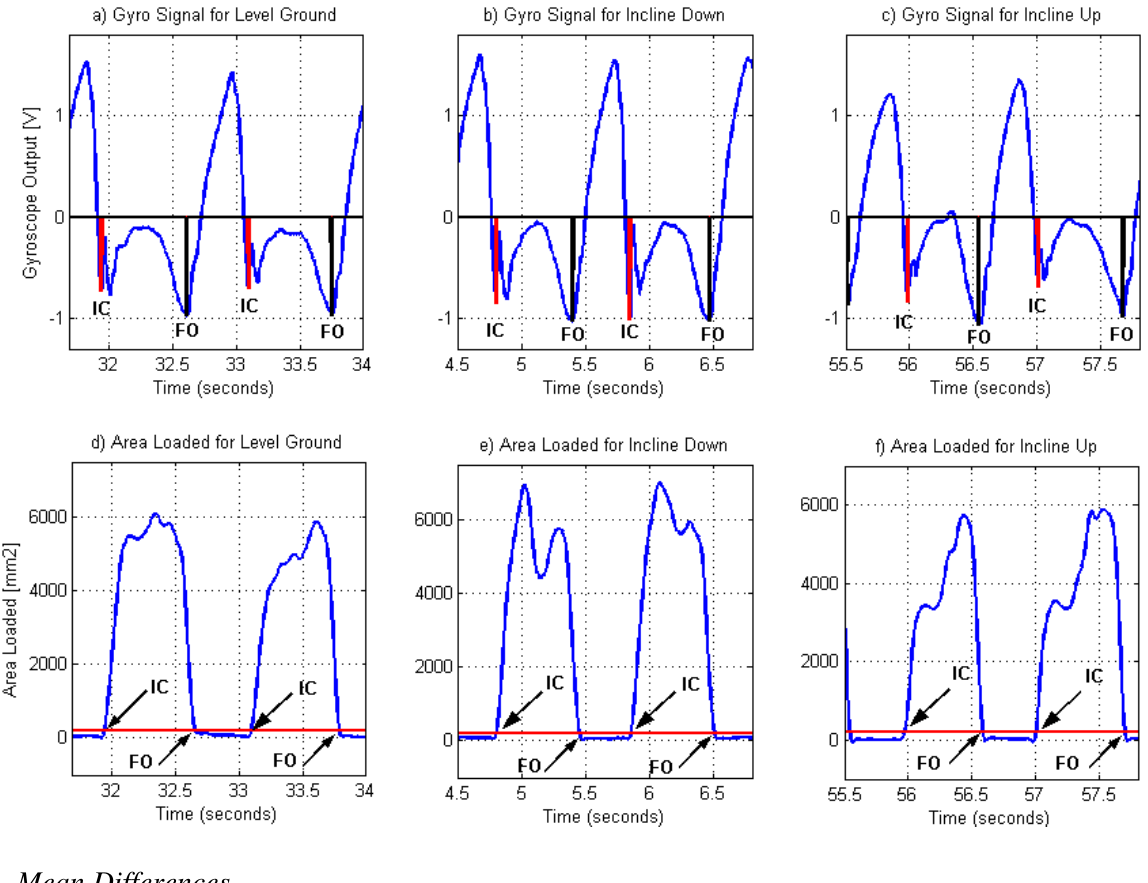
Figure 4. Gyroscope (a, b and c) and Contact Area loaded (d, e and f) signals from Subject 1. Vertical lines in the gyroscope graphs indicate the characteristic features of the gyroscope signal used for the detection of IC and FO events. (a) and (d) are the gyroscope and contact area loaded signals for the subject walking on level ground; (b) and (e) correspond to walking down the incline; and (c) and (f) correspond to walking up the